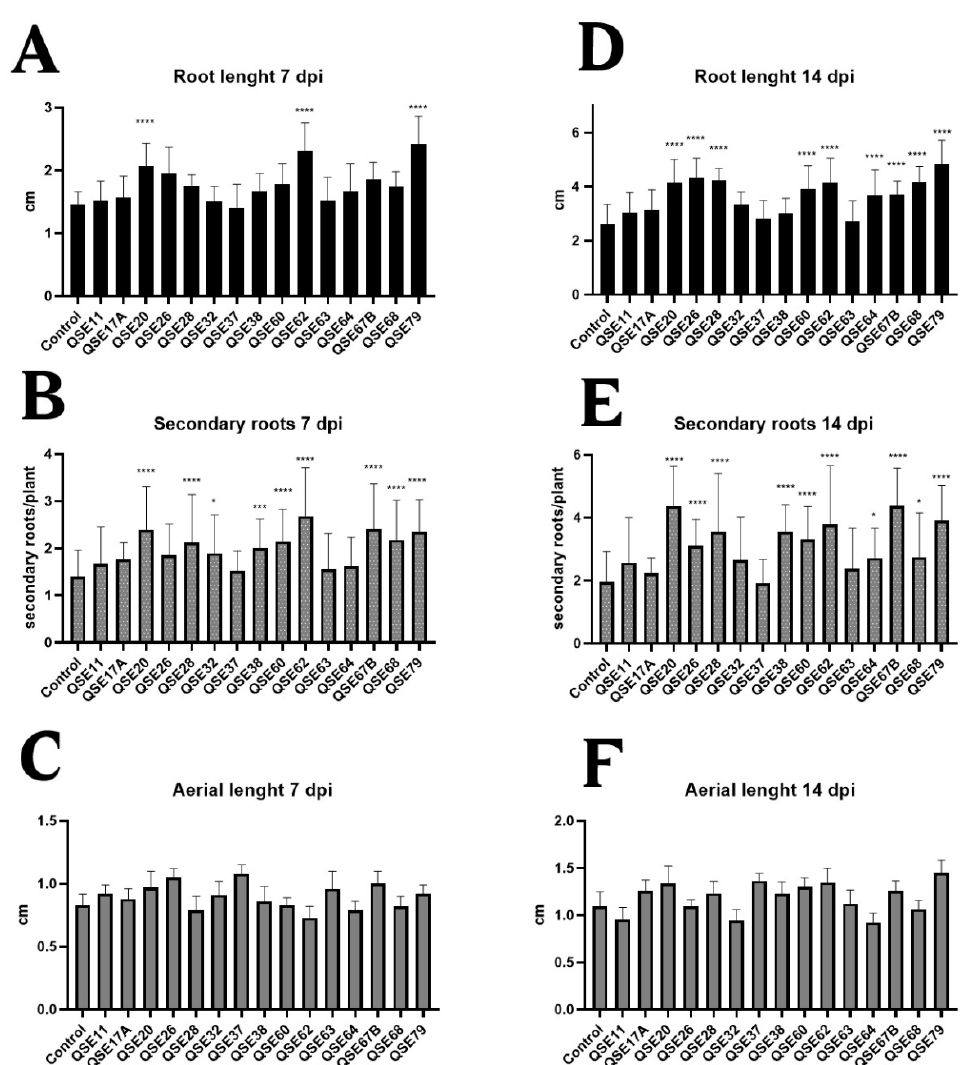
Figure 5. Results of plant growth promotion assay at 7 dpi ( A – C ) and 14 dpi ( D – F ). Statistical dif- ferences for each treatment with the uninoculated control treatment, according to Tukey compari- son tests at p ≤ 0.05 (*), p ≤ 0.0001 (***), p < 0.0001 (****).